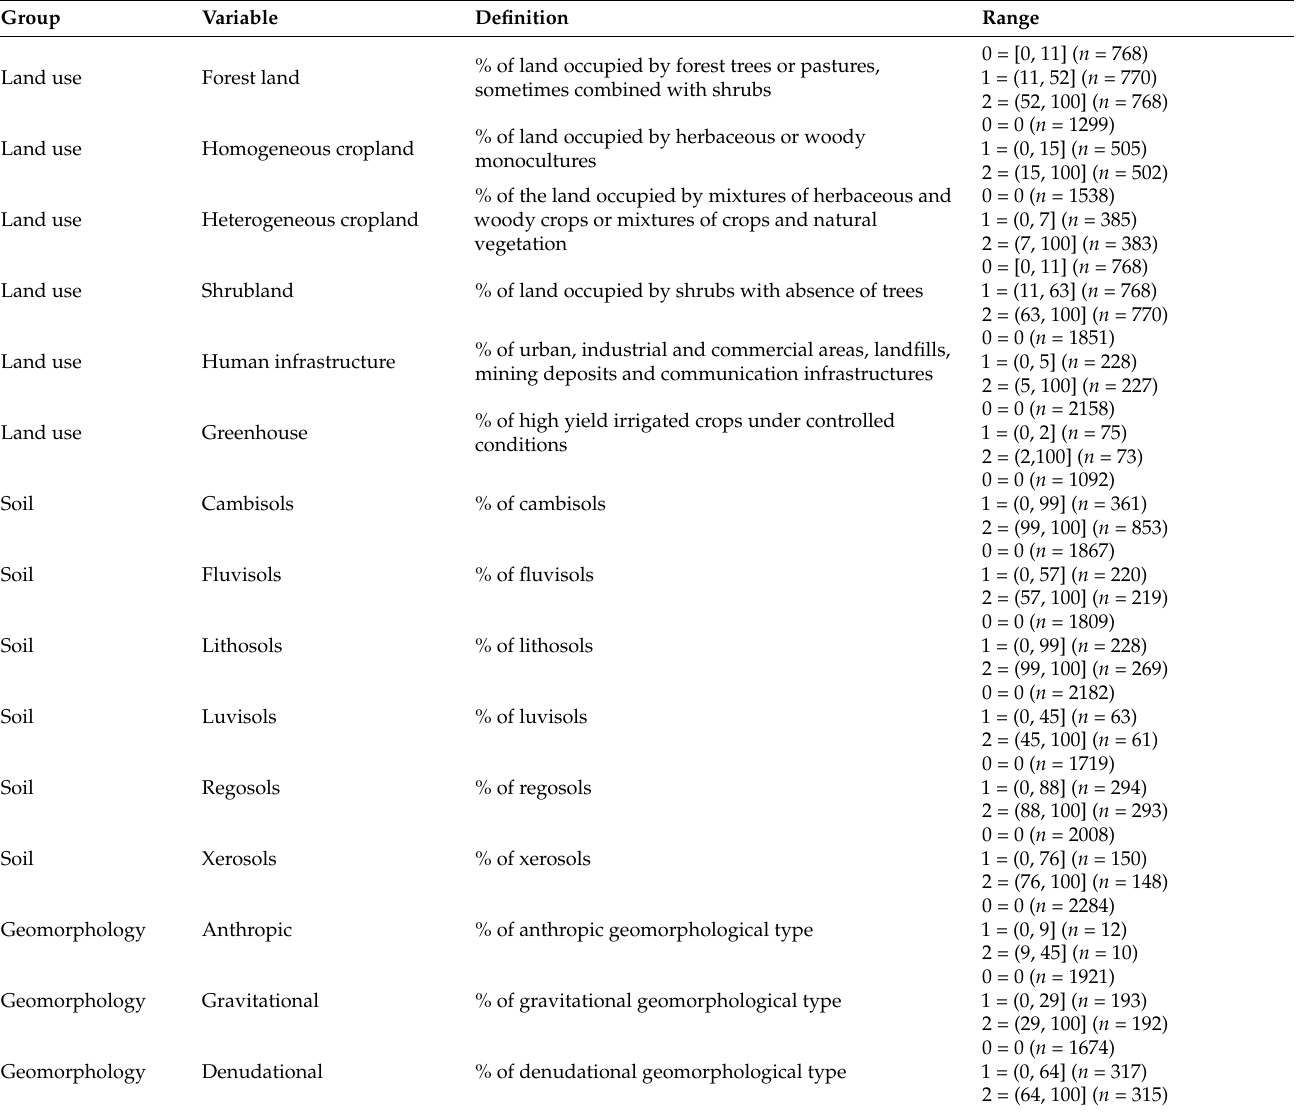
Table A1. Description of the land-related